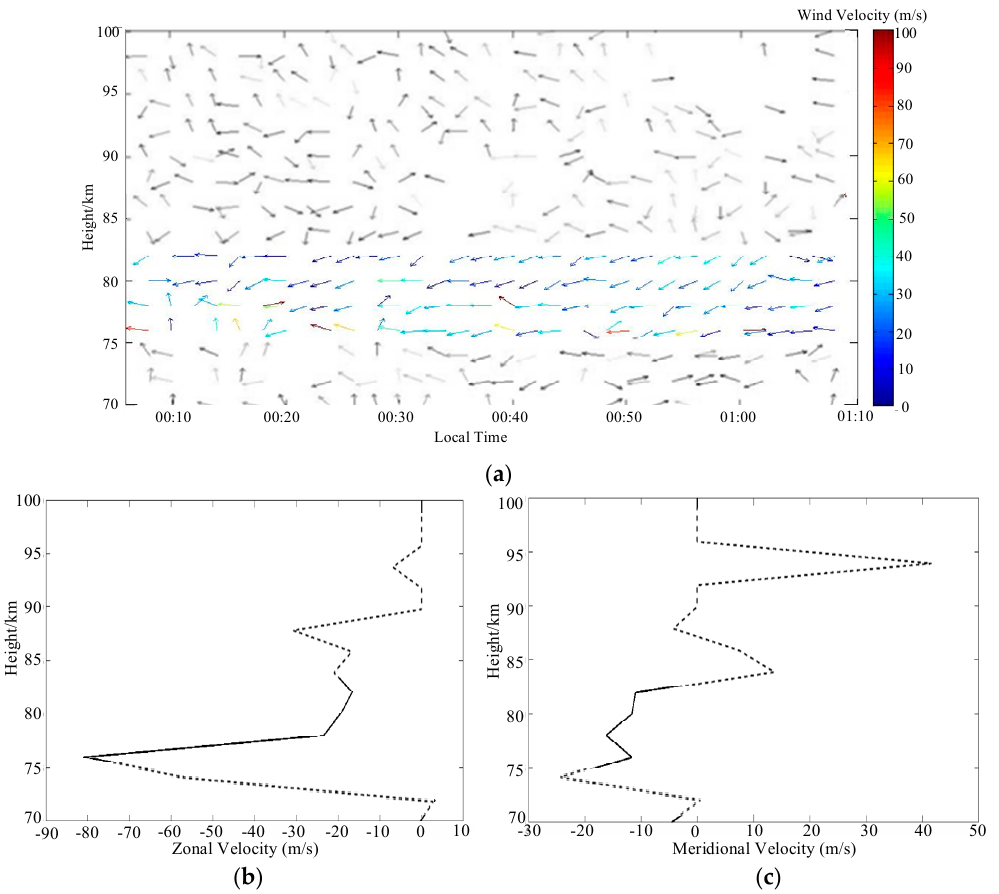
Figure 14. Wind field inversion results by FCA at the local time of 00:08-01:08, 1 January, 2018: ( a ) the temporal and spatial characteristics of wind field. Beyond 75 − 83 km, it is marked in gray for the less of accuracy ( b ) the zonal profile at 00:50; ( c ) the meridional profile at 00:50. Beyond 75 − 83 km, they are also marked as dashed lines.